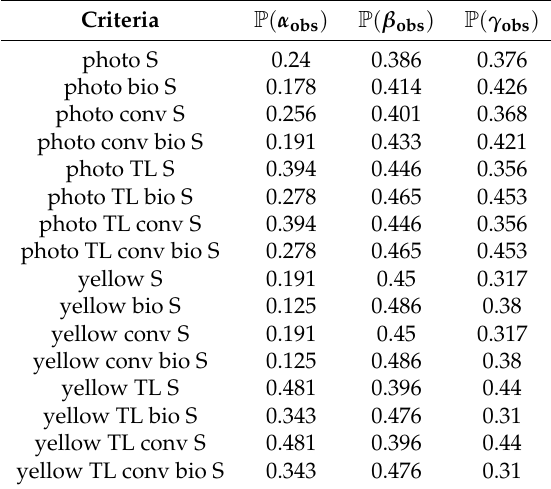
Table 3. Probabilities of observing our values of parameters for various habitability hypotheses with entropy condition (denoted by S) included. The other shorthands are the same as above. Criteria P p α obs